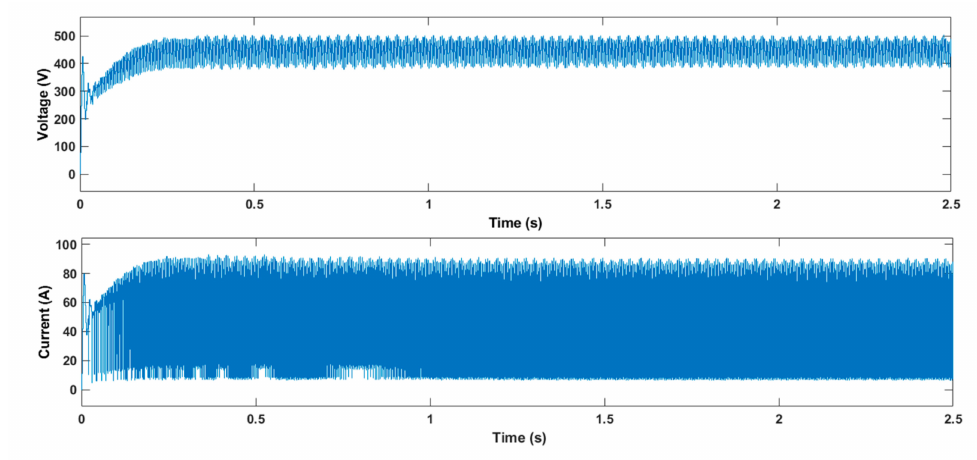
Figure 15. Boost converter output voltage and current using PI controller.